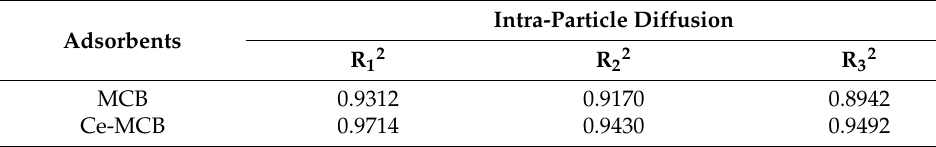
Table 3. The fitting parameters of intra-particle diffusion. Table 4. The fitting parameters of Elovich.